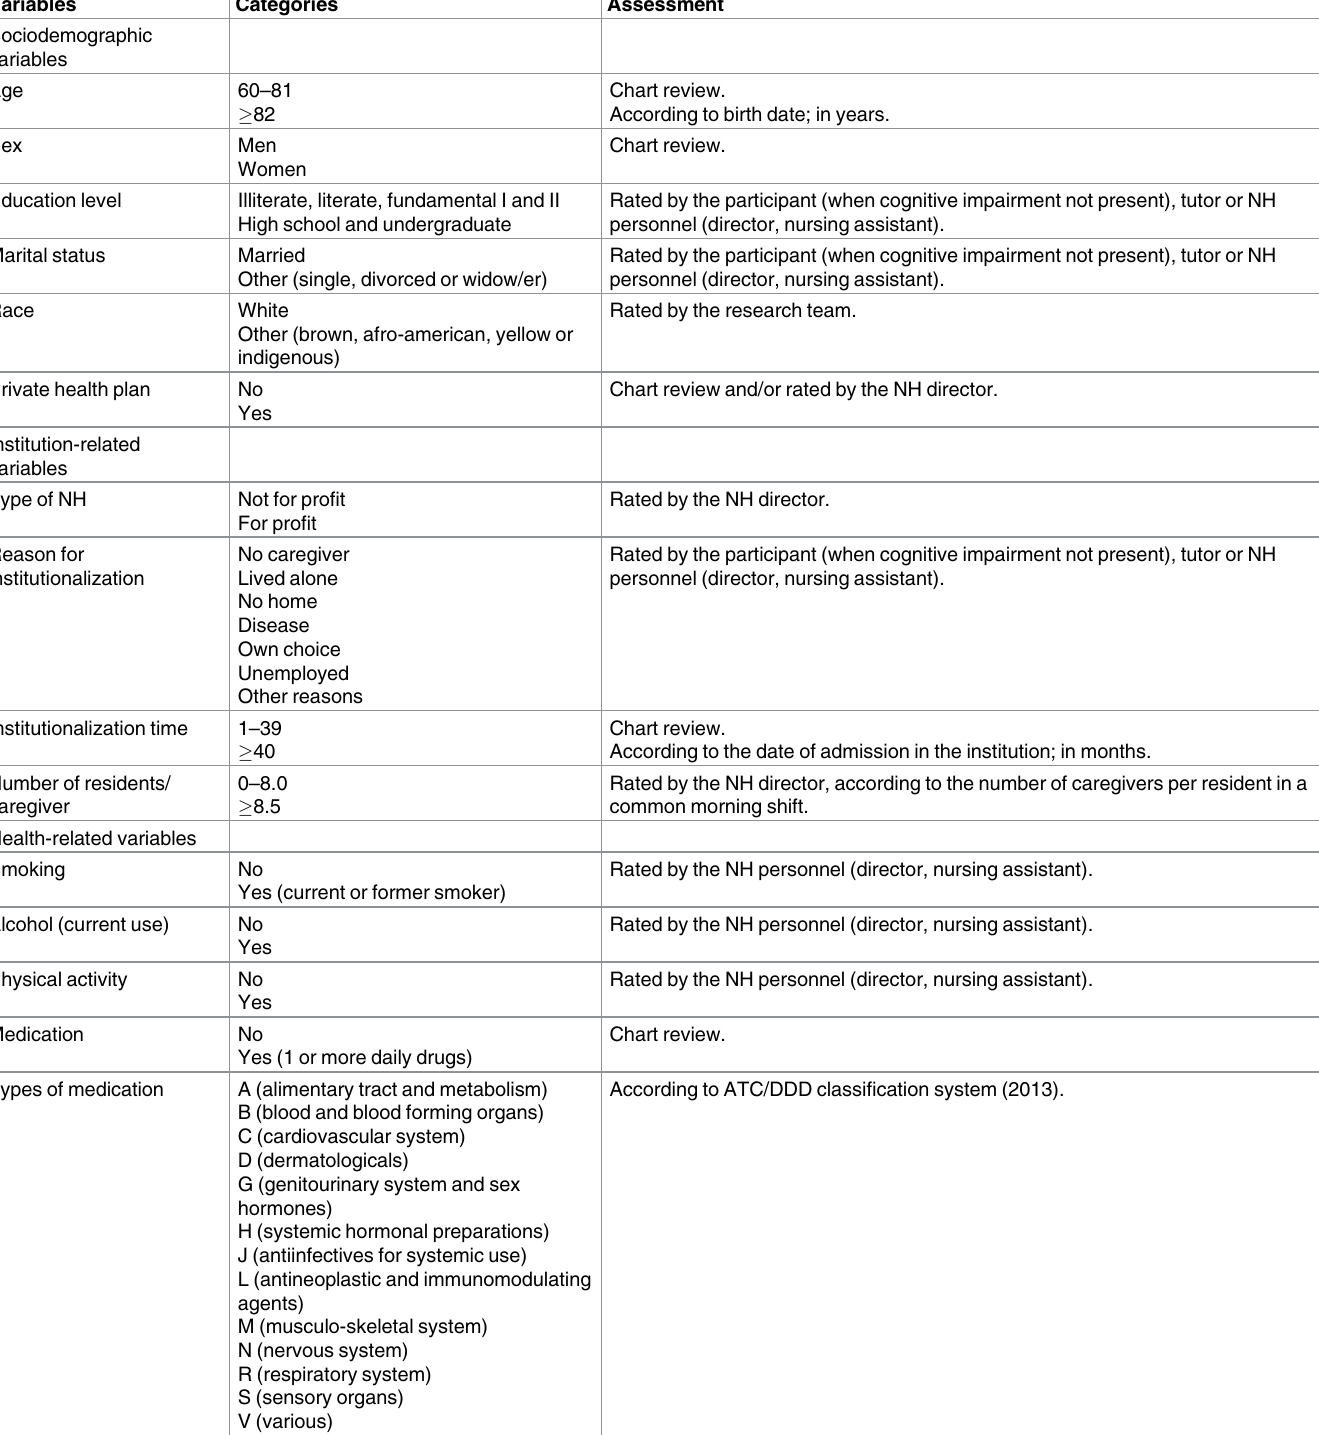
Table 1. Independent variables included in the study of functional decline in institutionalized older adults in Natal/RN. Natal/RN,